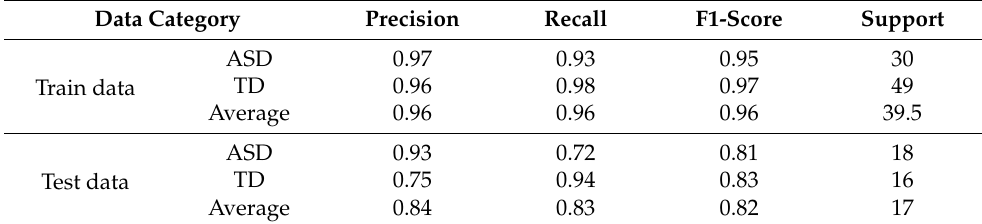
Table 5. Data table of model prediction